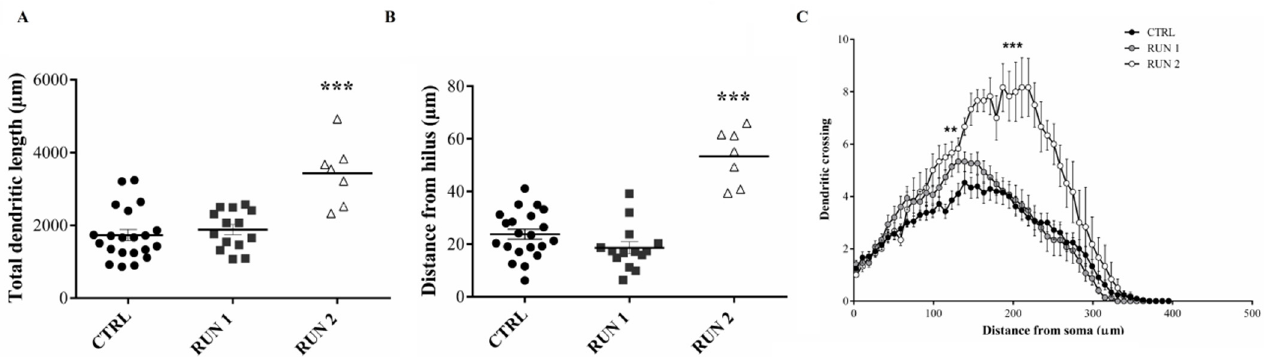
Figure 9. Morphological properties of CTRL, RUN 1, and RUN 2 30-day-old granule cells. Comparison of total dendritic length ( A ), distance of neuronal body from hilar border ( B ), and dendritic tree complexity ( C ) between CTRL, RUN1, and RUN2 GFP-positive neurons. Statistical analyses: ( A ) unpaired Student’s t -test *** p < 0.001; ( B ) unpaired Student’s t -test *** p < 0.001; ( C ) two-way